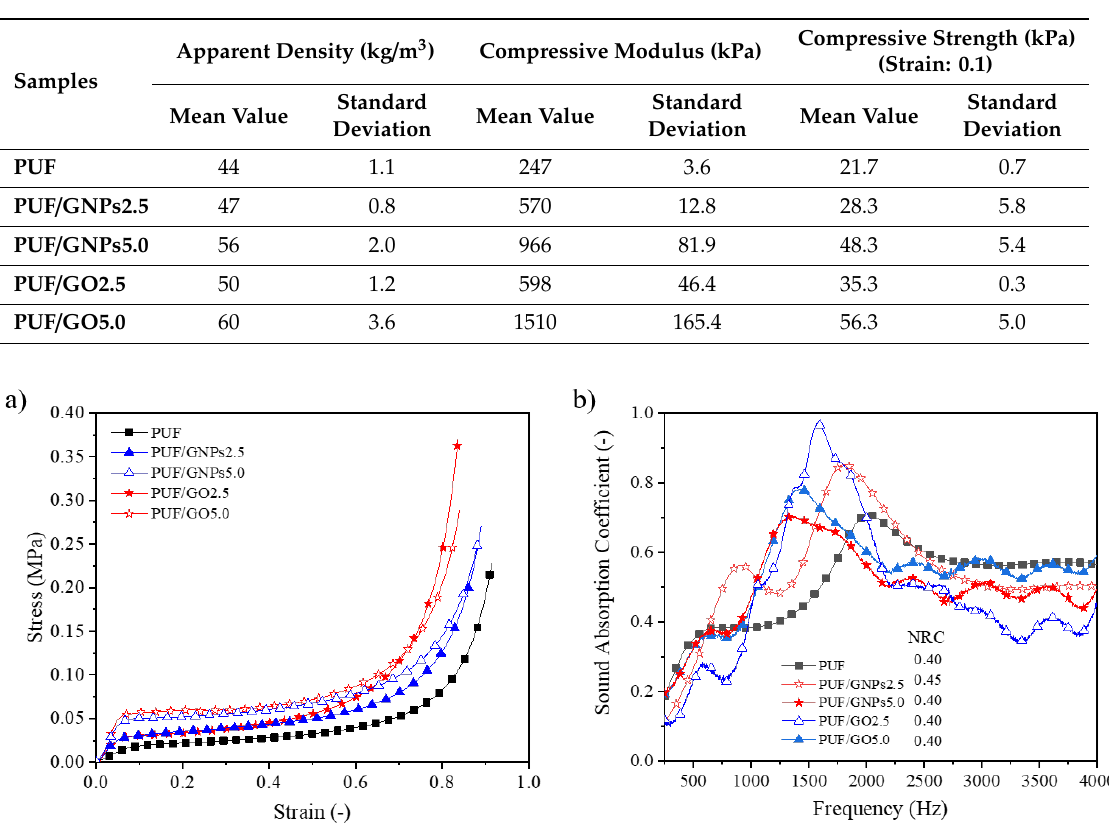
Figure 4. ( a ) Average stress–strain compressive curves; ( b ) the sound absorption coefficient of the different PU based composite